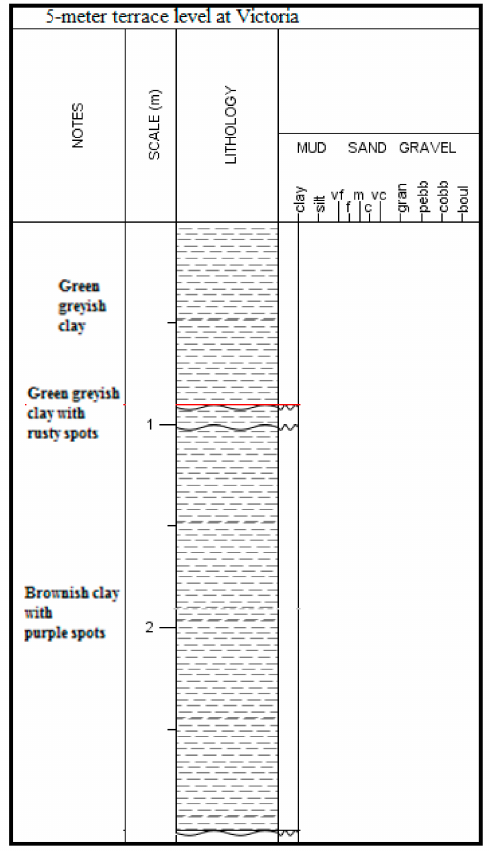
Figure 10. Sediment log of drilling core in the 5-m terrace level at Victoria. At Brokopondo Sula, further upstream between Victoria and the Afobaka Dam, a 5- m terrace level is present on an island in the middle of the river. A profile across the island was obtained for the purpose of exploring a possible dam site [52]. The profile shows an irregular bedrock surface at 7 to 12 m depth, covered by a fluvial fining upward sequence, with coarse sand at the bottom and loamy sand at the top (Figure 11)